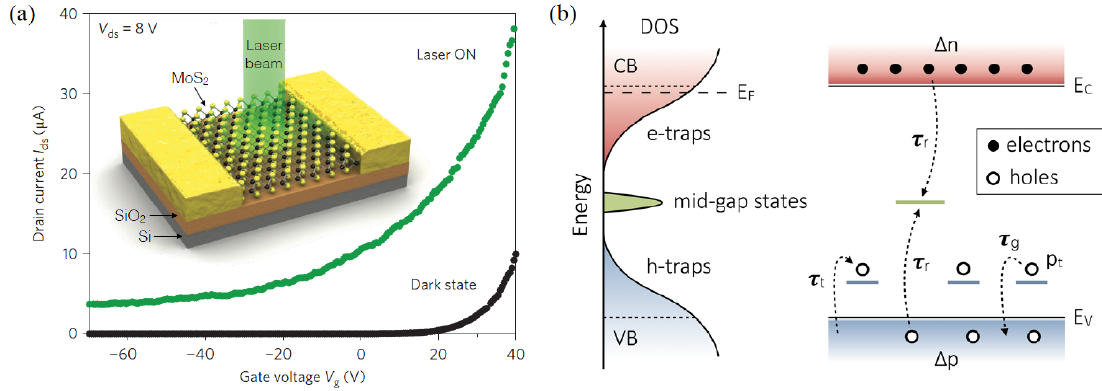
Figure 2. ( a ) Inset: Transition metal dichalcogenides TMD field-effect transistor as a photodetector. Main panel: typical gating characteristics with and without illumination. Reproduced with permission from [40], Copyright Nature Publishing Group, 2013. ( b ) Left: density-of-states (DOS) in MoS 2 . Band tail states exist underneath and above the conduction and valence band edges, respectively, that act as charge traps. Right: simplified energy band diagram that approximates the valence band tail by a discrete distribution of trap states. Reproduced with permission from [41], Copyright American Chemical Society,